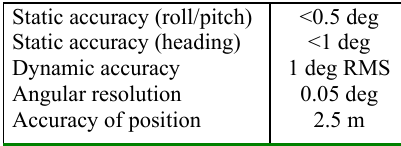
Table 2. Accuracy of MTi-G in position and attitude.